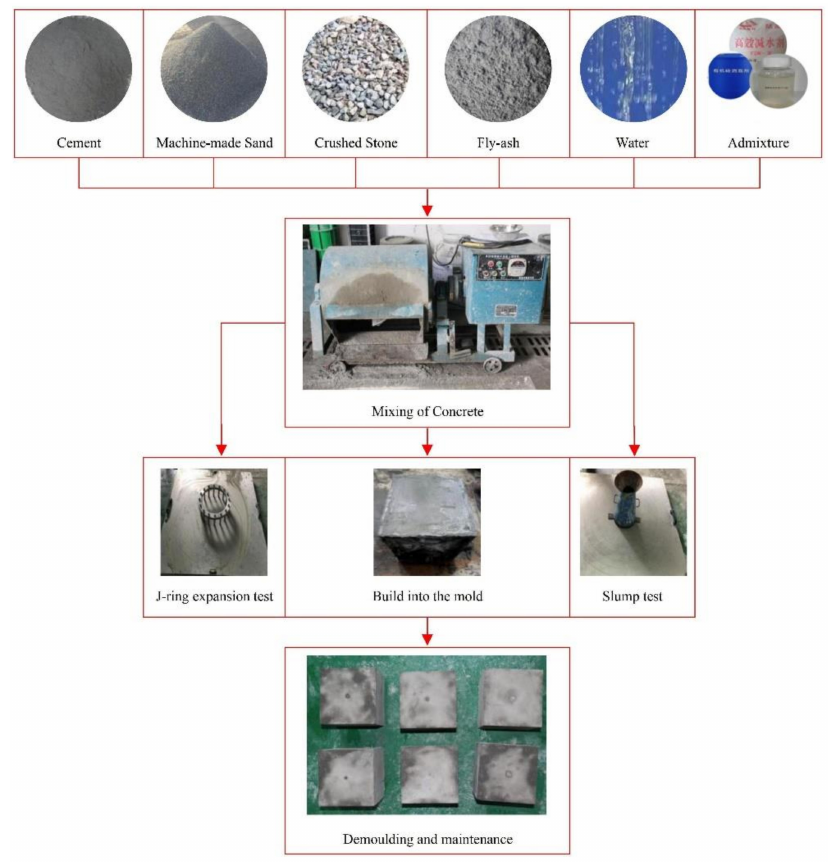
Figure 5. Preparation process of concrete